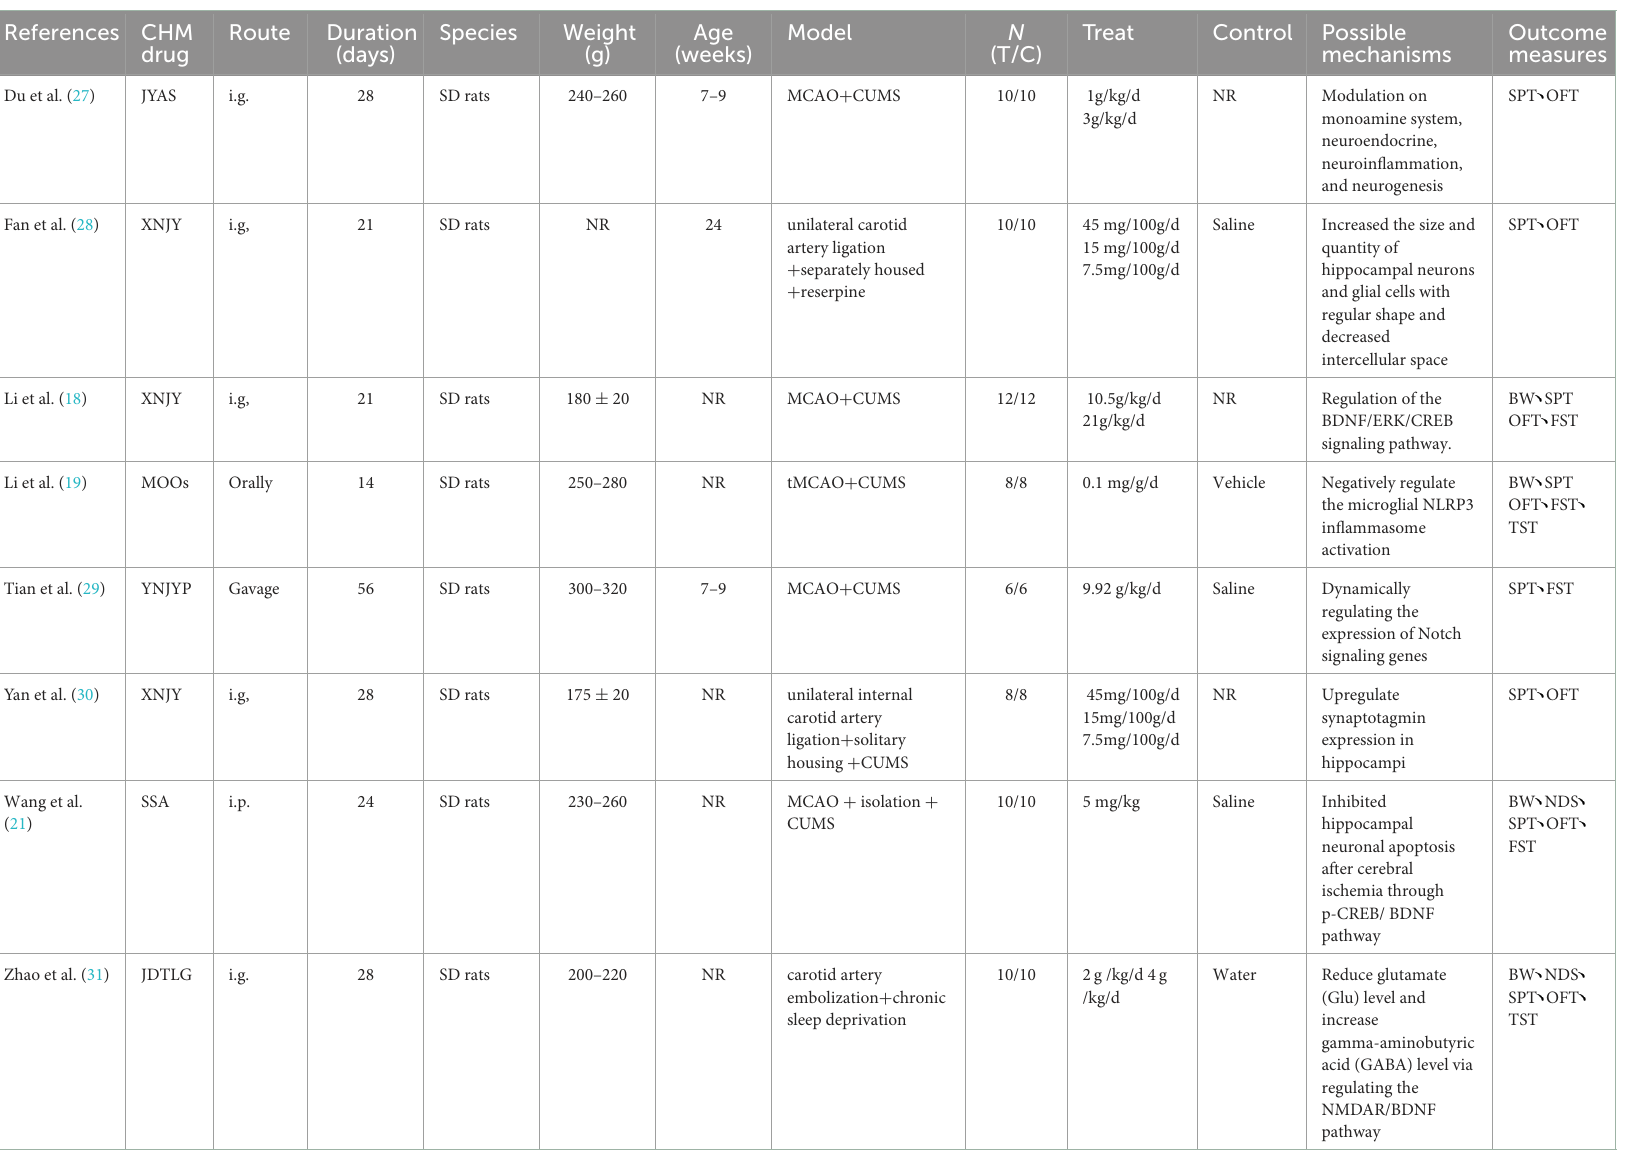
TABLE 1 Characteristicsof included